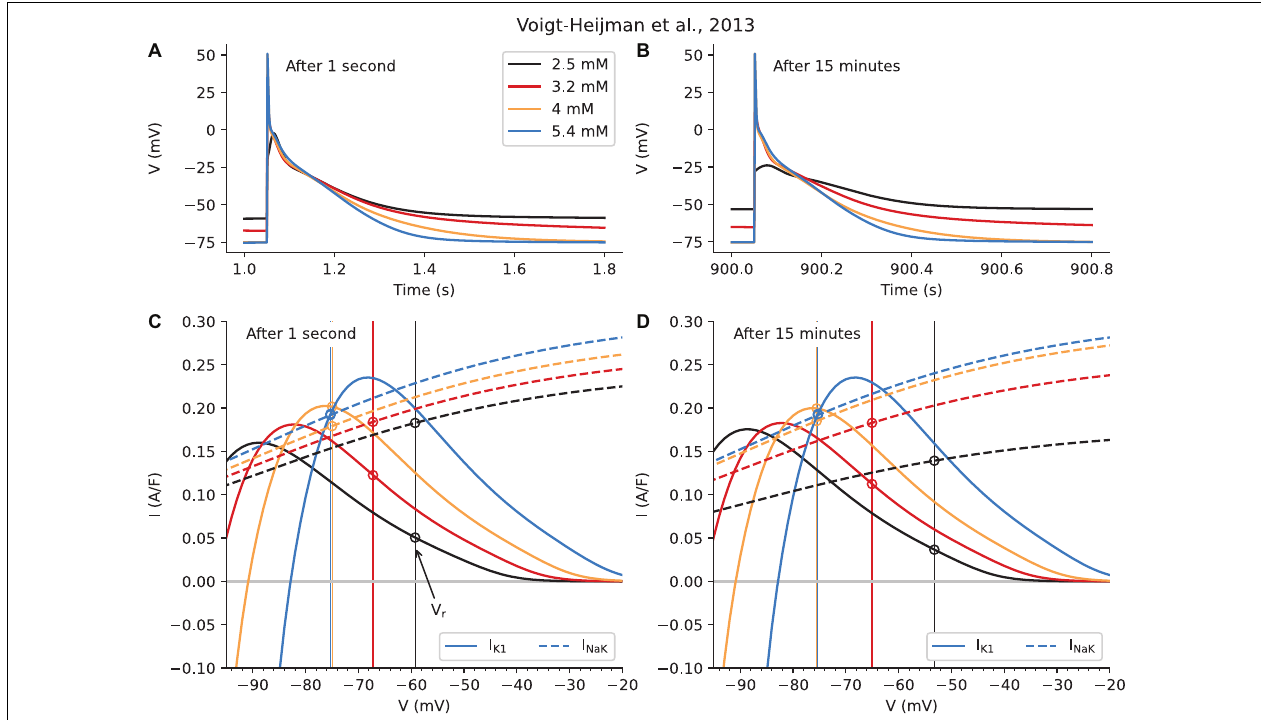
FIGURE 3 | Evaluation of the Short- and Long-Term Physiological Effects of Changes in [K + ] o on the Background K + Current, I K1 , and the Na + /K + Pump Current, I P . Data in the left column (A, C) was obtained 1 s after changing from 5.4 mM to the shown levels of [K + ] o ; the results in the right column (B, D) are 15 min after changes in [K + ] o . The superimposed AP traces in (A) are similar to those in Figure 2 and are included here to provide a direct comparison of very rapid short-term changes in [K + ] o with those that develop in a time-dependent fashion, shown in (C) . Note that the overall patterns of changes in V r and AP waveforms are similar when captured at 1 s vs. at 15 min. However, at 15 min in hypokalemic conditions (2.5 and 3.2 mM [K + ] o ) V r depolarizes slightly more and the final phase of AP repolarization is slowed markedly. Note also the very small depolarization observed for 2.5 mM after 15 min. (C, D) provide a direct comparison of the size and voltage-dependence of I K1 and I NaK . Side-by-side comparison of these two components reveals that, as expected, there is a time-dependent decrease in I NaK in the two hypokalemic [K + ] o conditions (3.2 and 2.5 mM). This, and the decrease in the outward current due to I K1 , are primary reasons that V r depolarizes to a new stable level. By contrast, the initial [K + ] o induced reduction in I NaK seen when switching from 5.4 to 4 mM is almost fully restored after 15